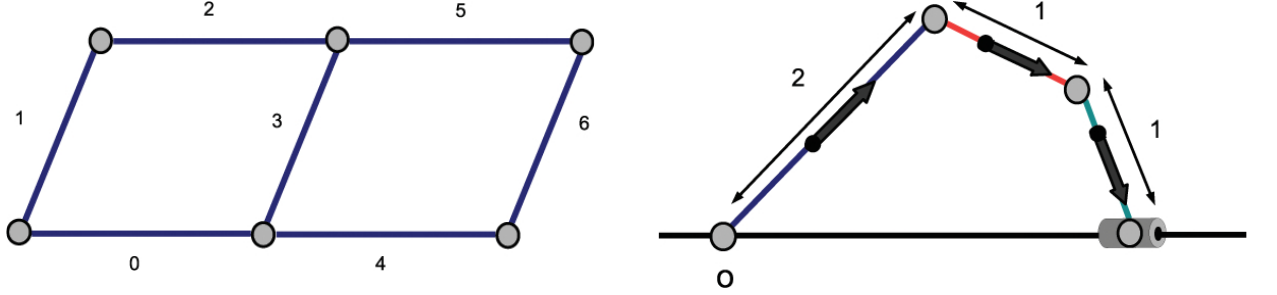
Figure 7. A configuration for numerical test problem in Gonz´alez et al. (2006).